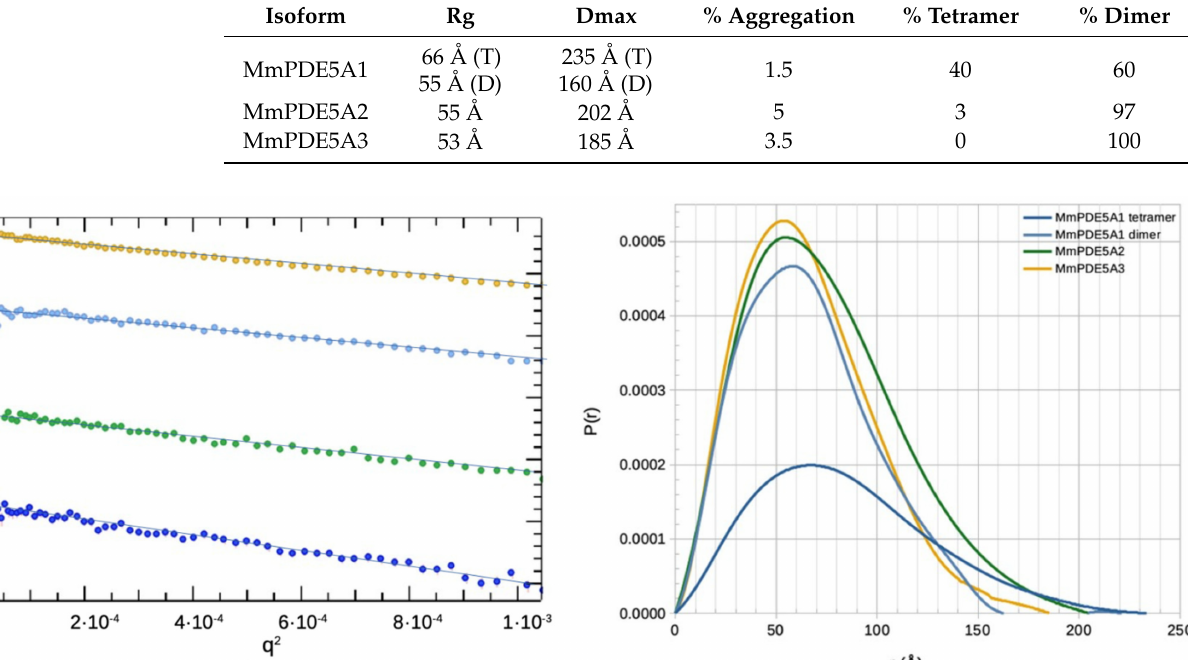
Figure 2. Summary of SAXS analysis. Left panel: Guinier analysis of I(q) as a function of q 2 of deconvoluted data. From top to bottom, there are MmPDE5A3 (orange), MmPDE5A2 (green), MmPDE5A1 dimer (light blue) and MmPDE5A1 tetramer (dark blue). Right panel: GNOM analysis of the probability function after